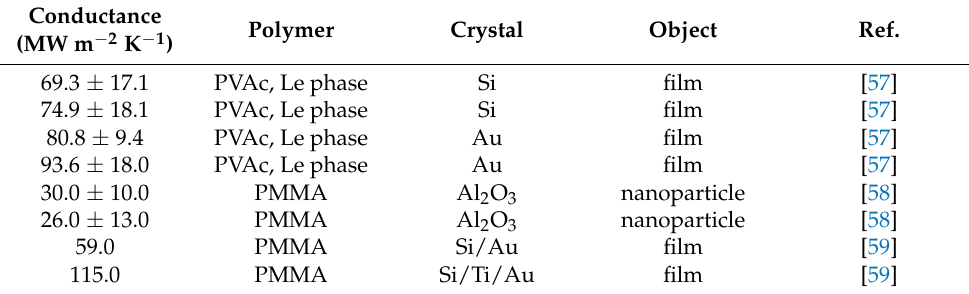
Table 3. The literature data on Kapitza conductance.